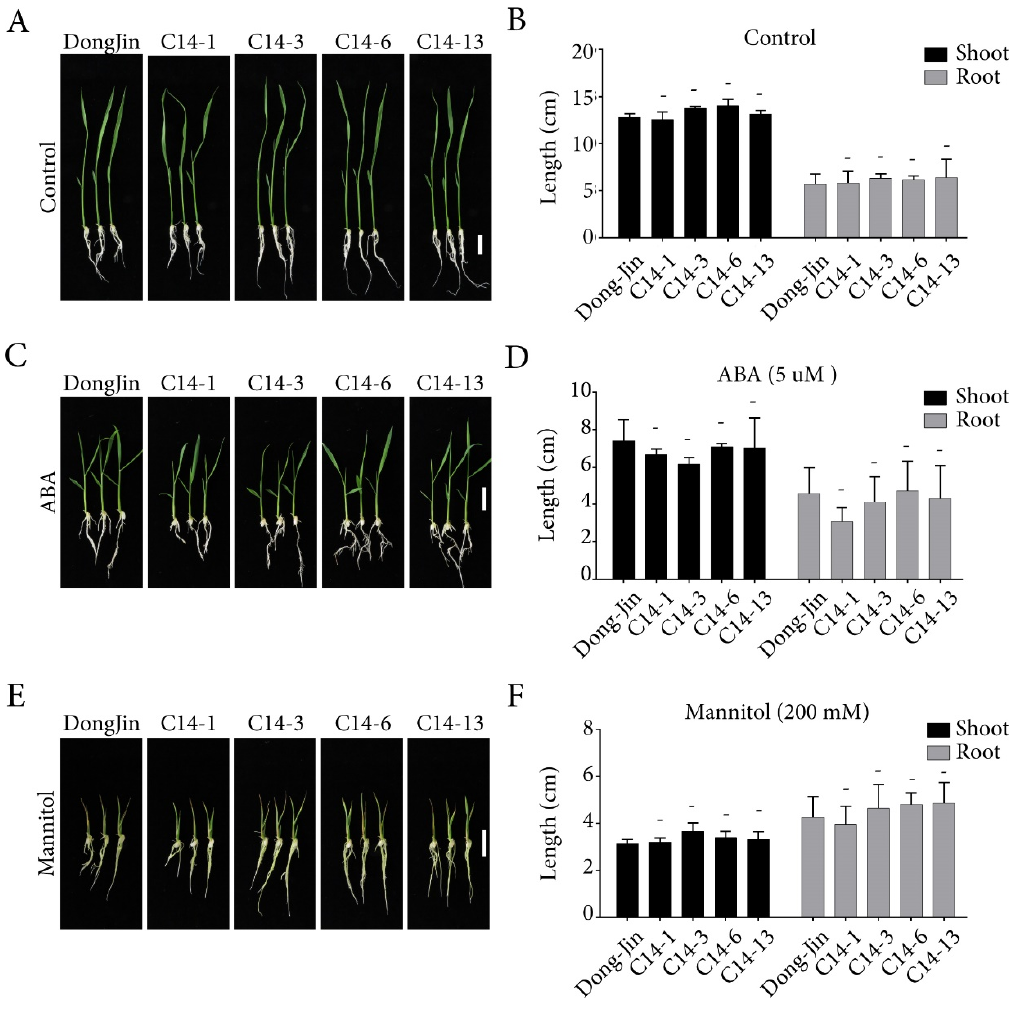
Figure 2. Post-germination assay of transgenic rice lines overexpressing OsPYL / RCAR7 under abscisic acid (ABA) treatment and osmotic stress conditions. ( A , C , E ) Representative images of rice seedlings grown on media, 1/2MS, supplemented with 5 μM ABA and 200 mM mannitol. ( B , D , F ) Quantitiative data of the post-germination assay. No significant differences were detected. The graphs show average values with standard error ( n = 5). Three indepent experiments were performed and showed similar results in every repeats. Representative results were presented. – means no significance.